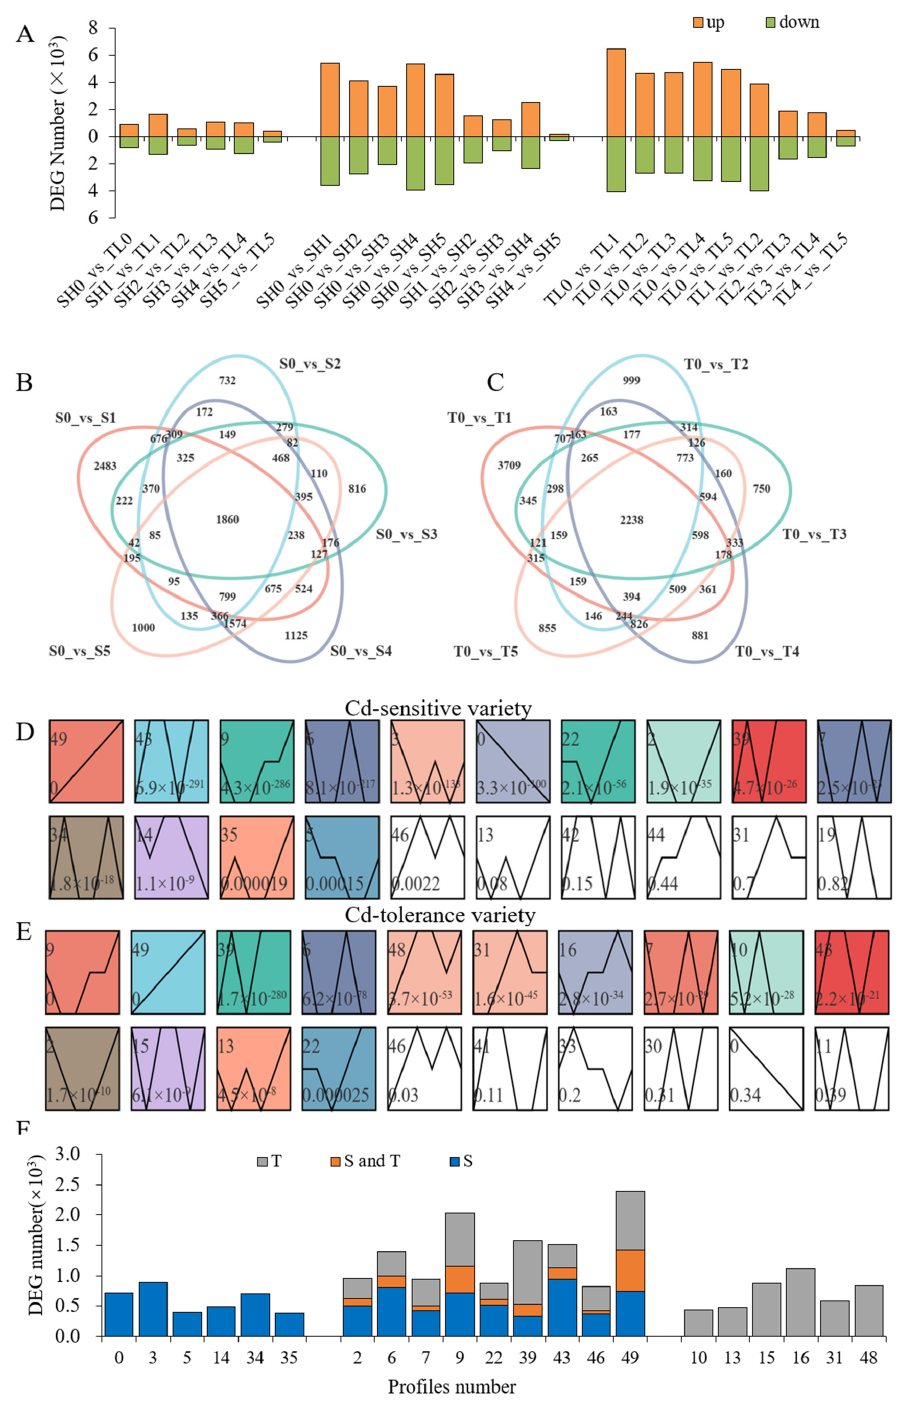
Figure 4. The number of differentially expressed genes (DEGs) between the two varieties and between different Cd stress time points ( A ). Venn analysis of DEGs between control and Cd stress conditions in the Cd-sensitive variety ( B ) and Cd-tolerant variety ( C ). Short Time-Series Expression Miner (STEM) analysis of DEGs in the Cd-sensitive variety ( D ) and Cd-tolerant variety ( E ). Summary of DEGs in each profile with a significant change trend ( F ). S0, S1, S2, S3, S4, and S5 represent Cd-sensitive variety under control, 6 h, 1-day, 3-day, 7-day, and 14-day Cd treatments, respectively; T0, T1, T2, T3, T4, and T5 represent Cd-tolerant variety under control, 6 h, 1-day, 3-day, 7-day, and 14-day Cd treatments,